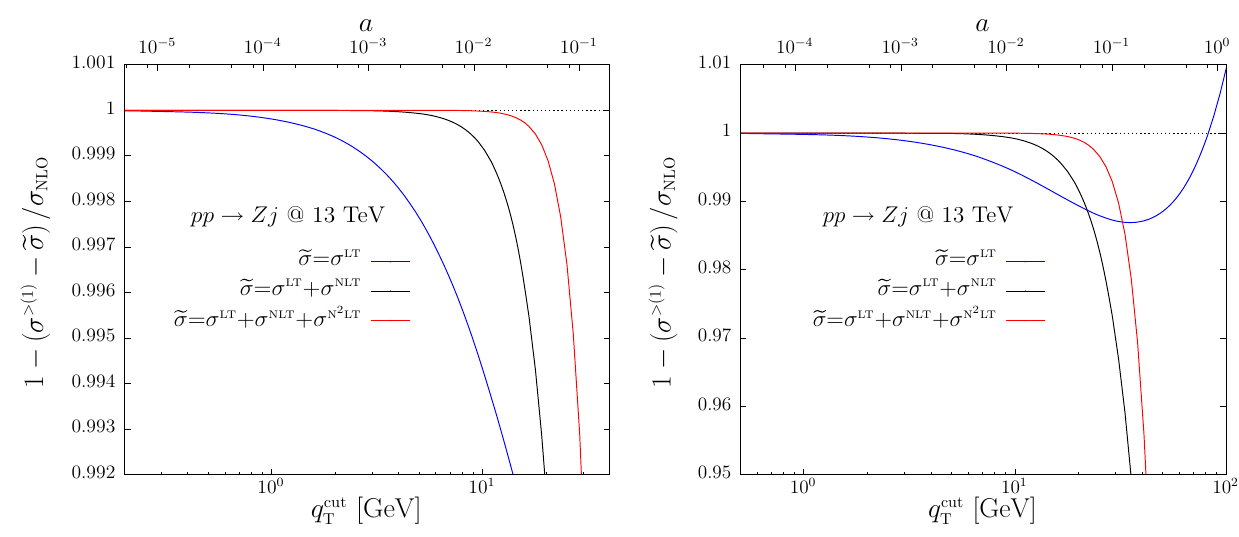
(cid:9) (cid:10) σ >( 1 ) − ! σ /σ Fig. 3 Results for 1 − NLO as a function of q boson production, in pp → Zj . Same legend as in Fig. 1. In the left pane, the low- q cut region is displayed, while, in the right pane, a larger T